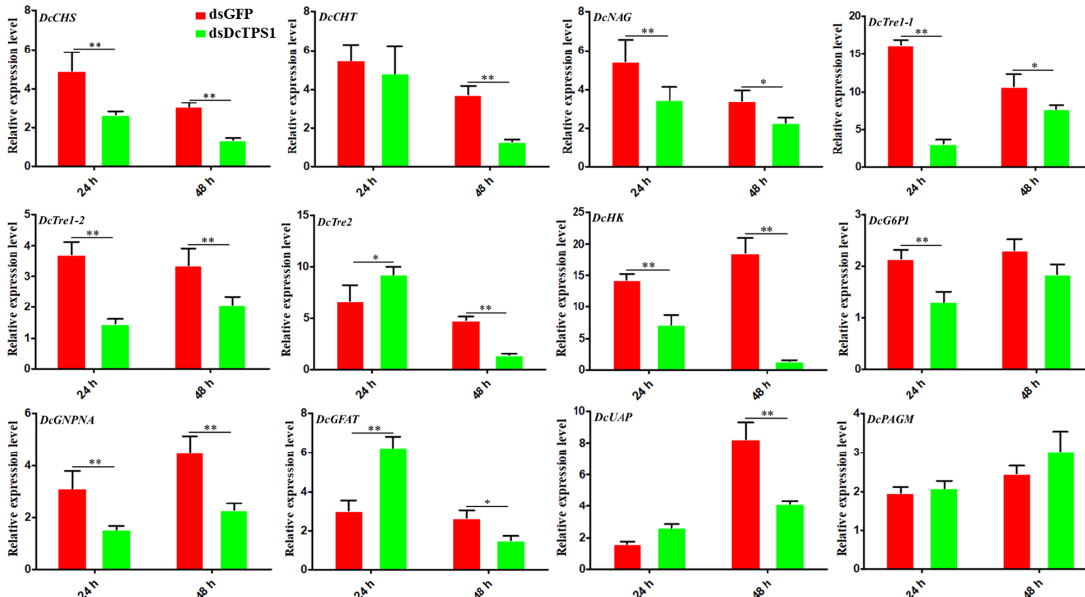
Figure 6. Analysis of expression levels of chitin metabolism-related genes after inhibition of DcTPS1 . The ds GFP treatment group was used as a control. The mean expression level represents three biological replicates. The asterisks indicate significant differences by * p < 0.05 and ** p < 0.01. The SPSS software was used to conduct statistical analysis.